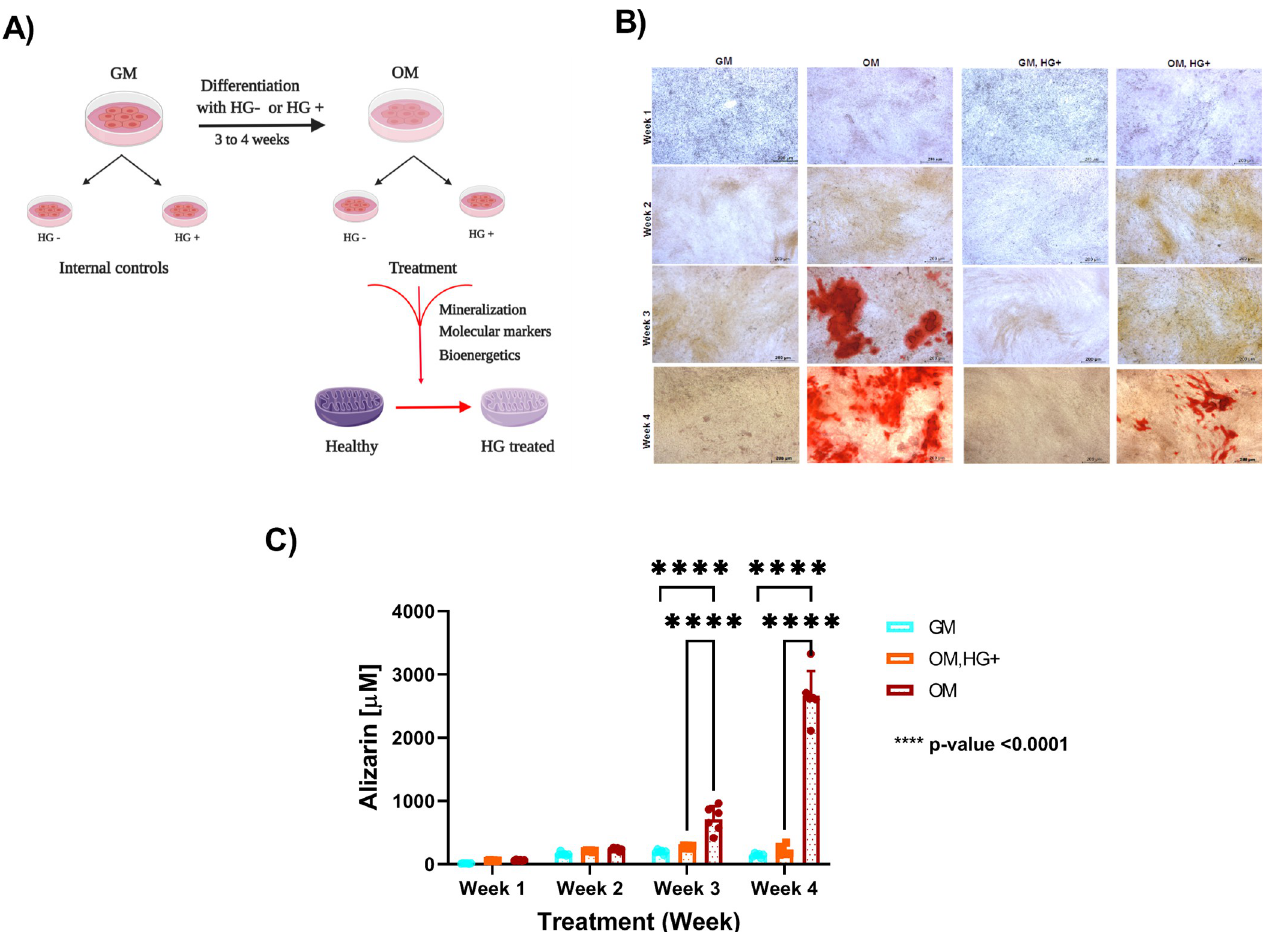
Fig 1. Alizarin S red staining of MC3T3 cells undergoing differentiation in the presence (OM, HG+) or absence of high glucose (OM). A. Schematic of Type 2 diabetes (T2D) protocol in vitro . B. Qualitative analysis of Alizarin S Red staining using one out of six biological replicates � . C. Quantitative analysis of Alizarin S red staining comparing MC3T3 nondifferentiated (GM) and differentiated (OM) cells. D. Quantitative analysis of Alizarin S red staining comparing differentiated MC3T3 cells under low glucose conditions (OM) and high glucose (OM, HG+) conditions. Error bars represent standard deviation (SD). Data were analyzed using Two-way ANOVA as described in methods. Abbreviations: GM = minimal growth media; OM = Osteogenic media; HG + = high glucose; HG- = low glucose. N = 6 per culture condition. One experiment was performed in triplicates per biological replicate at the end of each week for four weeks. � Created with